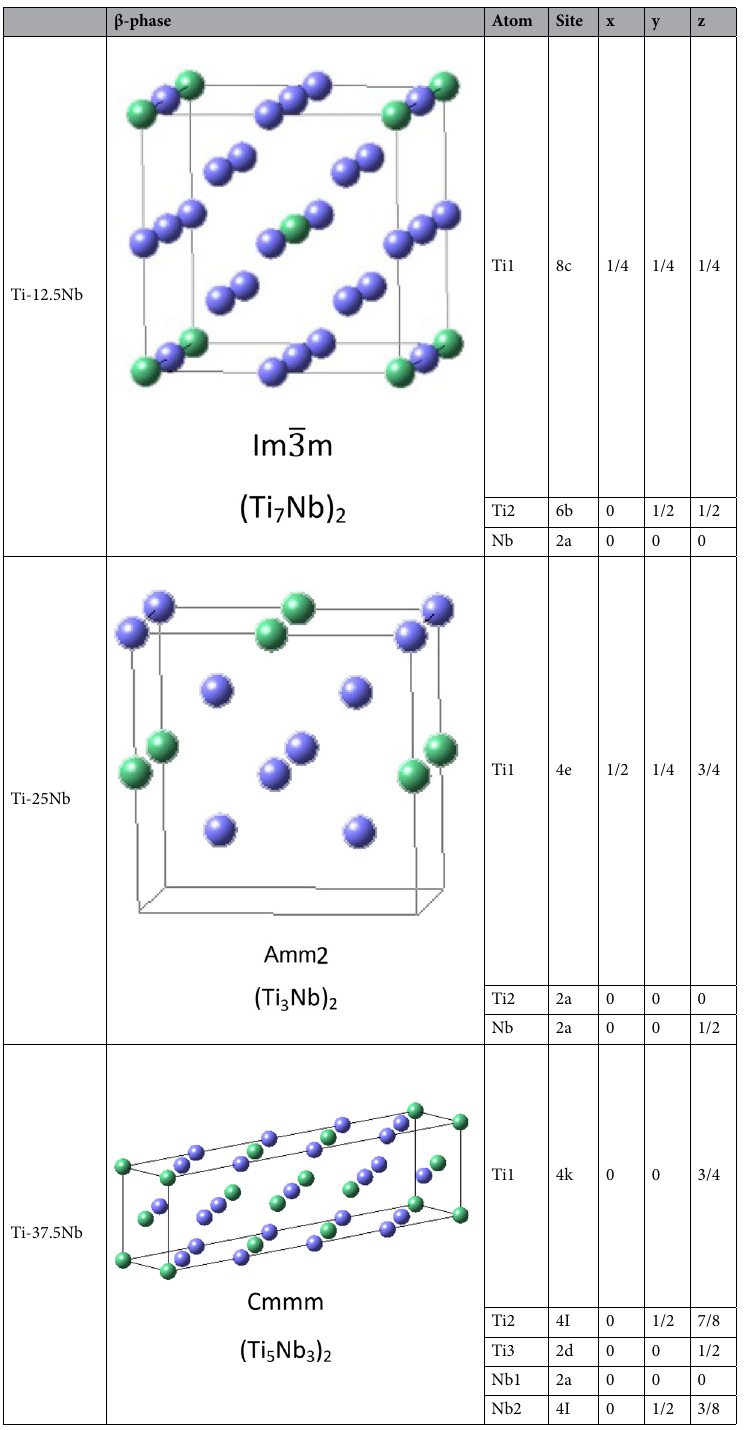
Table 5. CE predictions of stable β-phase structures in Ti–Nb binary. The blue and green atoms are respectively Ti and